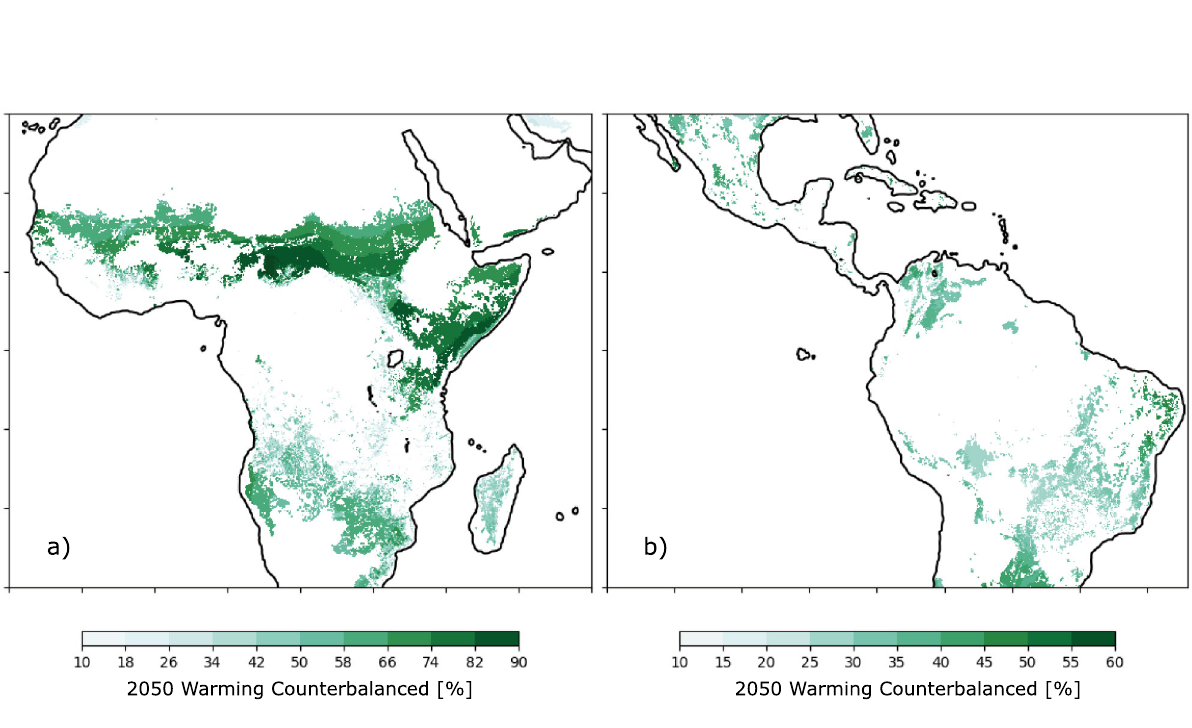
Fig. 4 Cooling potential of realistic silvopasture expansion. The percentage of warming expected in 2050 due to anthropogenic emissions that would be counterbalanced in ( a ) Africa and ( b ) the Americas if pasturelands, where woody carbon density is currently less than the biome median value, were increased to their biome median value (see Methods). Coastline data generated from A Global Self-consistent, Hierarchical, High-resolution Geography